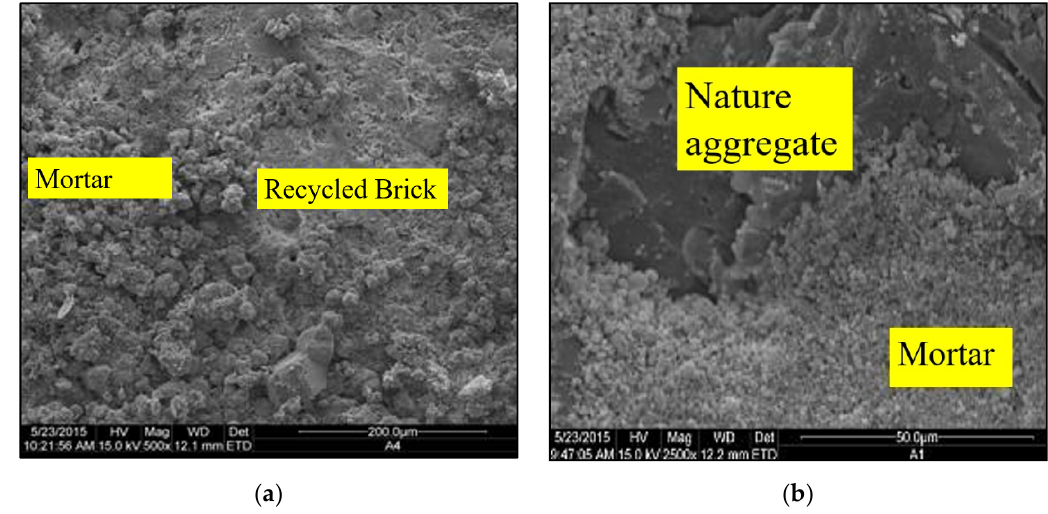
Figure 21. Microstructure analysis for CDW recycled concrete: ( a ) Bonding of mortar and recycled brick; ( b ) Bonding of mortar and nature